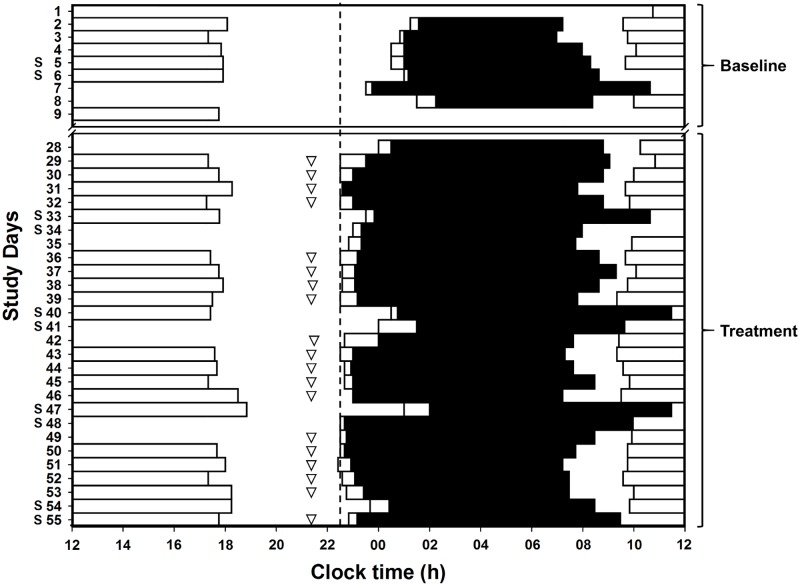
Raster plot of sleep-wake and work patterns for a representative DSWPD patient at baseline and during treatment with 0.5 mg melatonin.Black bars: sleep with open bar illustrating sleep onset time; triangles: time of melatonin administration; dashed line: DBT; open bars: work. On nights prior to daytime commitments on at least 5 nights per week, medication was taken 1 h before DBT identified prior to the study. DBT, desired bedtime; DSWPD, Delayed Sleep-Wake Phase Disorder.